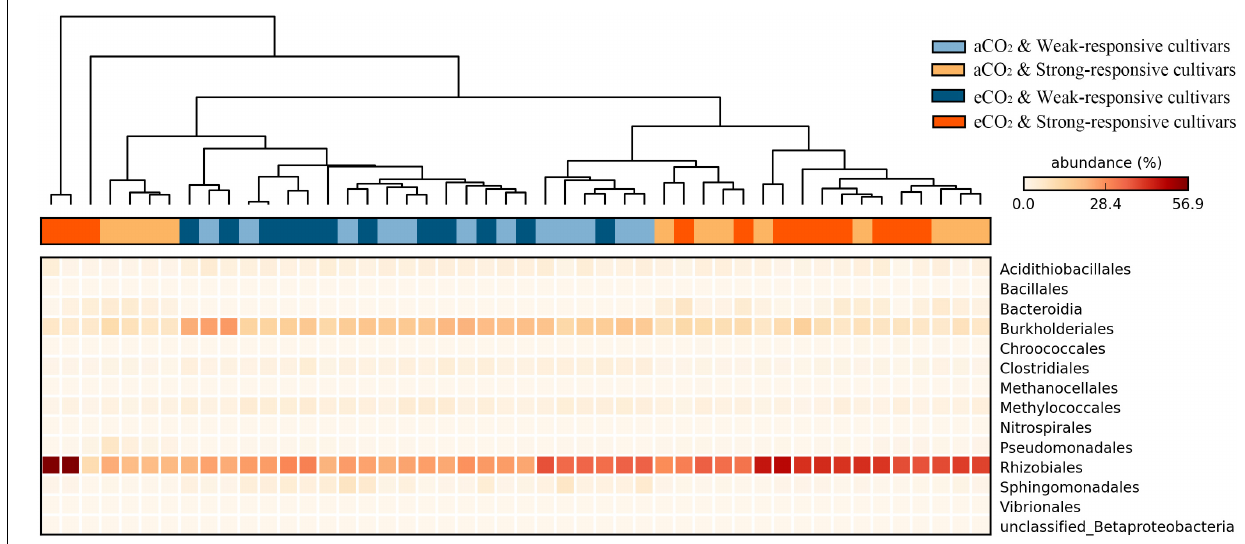
FIGURE 3 | Heatmap of the significant responded diazotrophs at order level in paddy soil with different treatments (Tukey–Kramer test, p < 0.05). The color intensity in each panel shows the relative abundance (percentage) of each phylotype at order level in each sample.